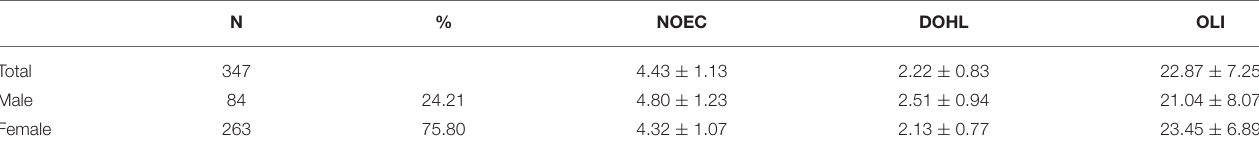
TABLE 1 | Behavioral engagement analysis.